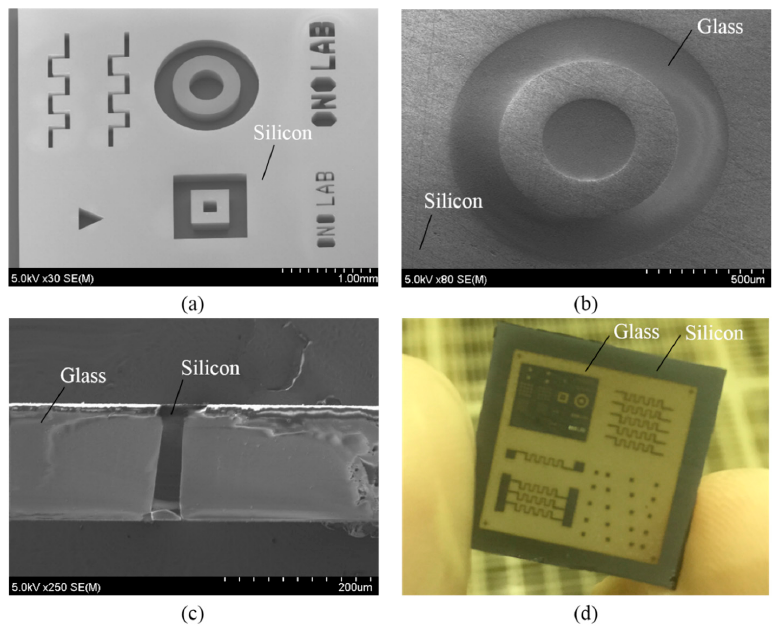
Figure 11. Glass reflow process. ( a ) Silicon mold; ( b ) glass reflow into silicon mold; ( c ) silicon through-glass wafer interconnects; ( d ) 2 cm × 2 cm glass-in-silicon wafer.